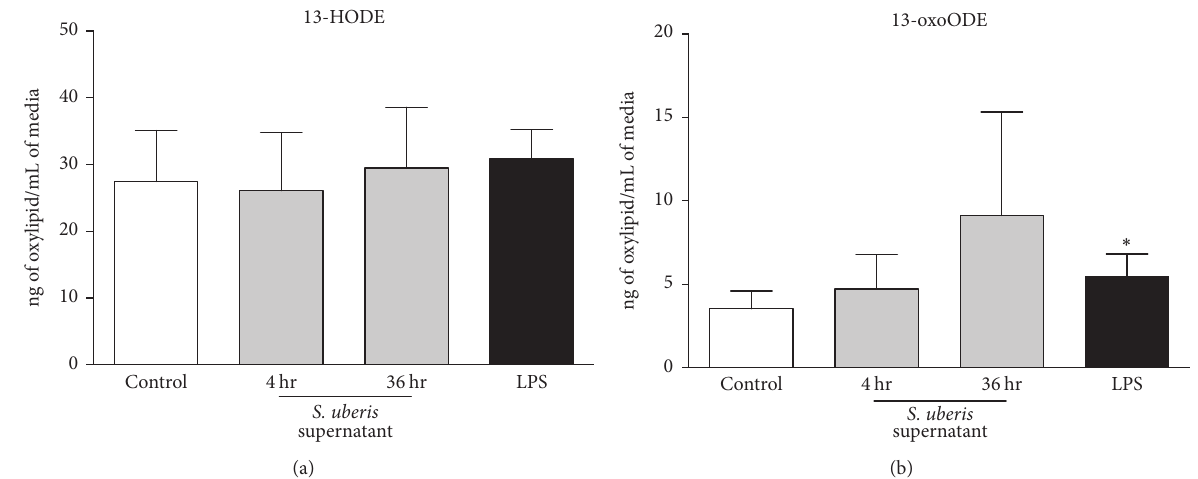
Figure 2: Endothelial oxylipid biosynthesis following 4 hr LPS (black bars) or S. uberis supernatant exposure for 4hr and 36hr (light grey bars) is displayed. Media controls are displayed as open bars. Mean oxylipid biosynthesis is expressed as ng of oxylipid/mL of media. Asterisks ( ∗ ) denote differences between media control and positive control (LPS) as tested by Student’s t -tests. Significance for differences declared at 𝑃 ≤ 0.05 ( 𝑛 = 3 ).